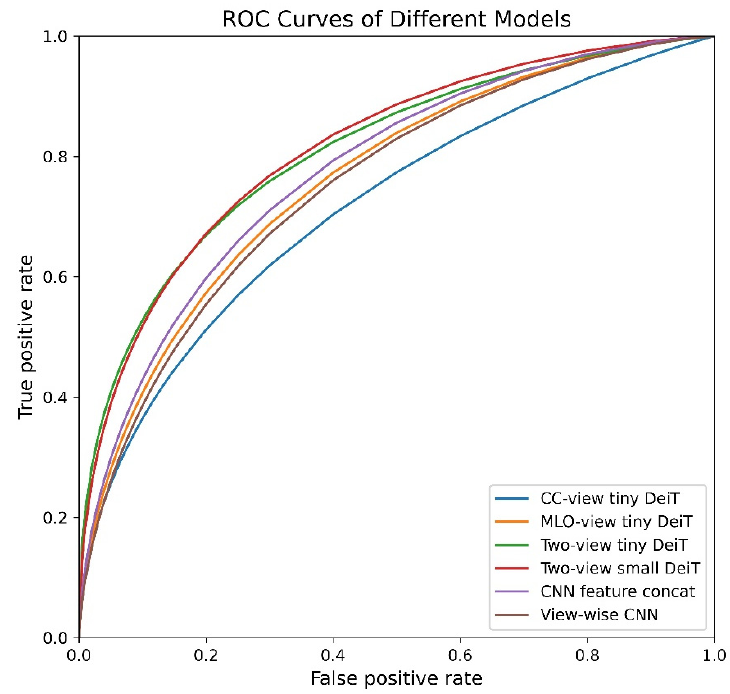
Figure 3. Illustration of 6 ROC curves of single-view transformers, multi-view transformers, and